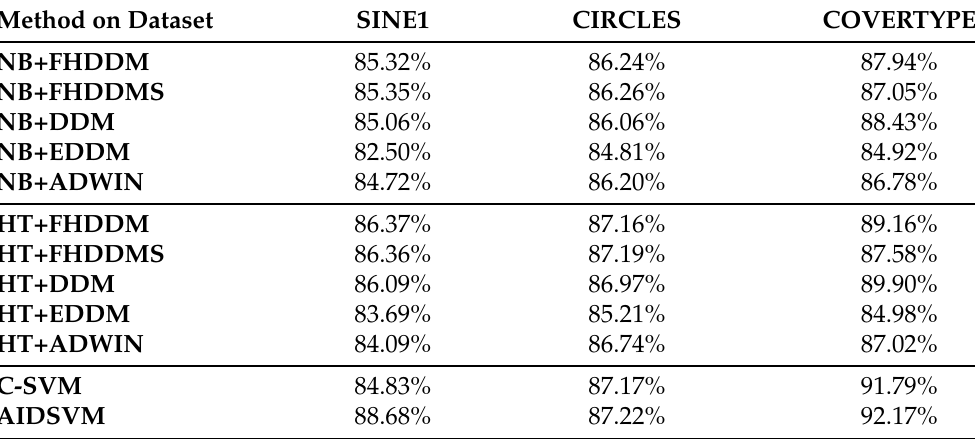
Table 2. Accuracy comparison between AIDSVM and other concept drift detectors, on given datasets. C-SVM was also evaluated, although its window size is not